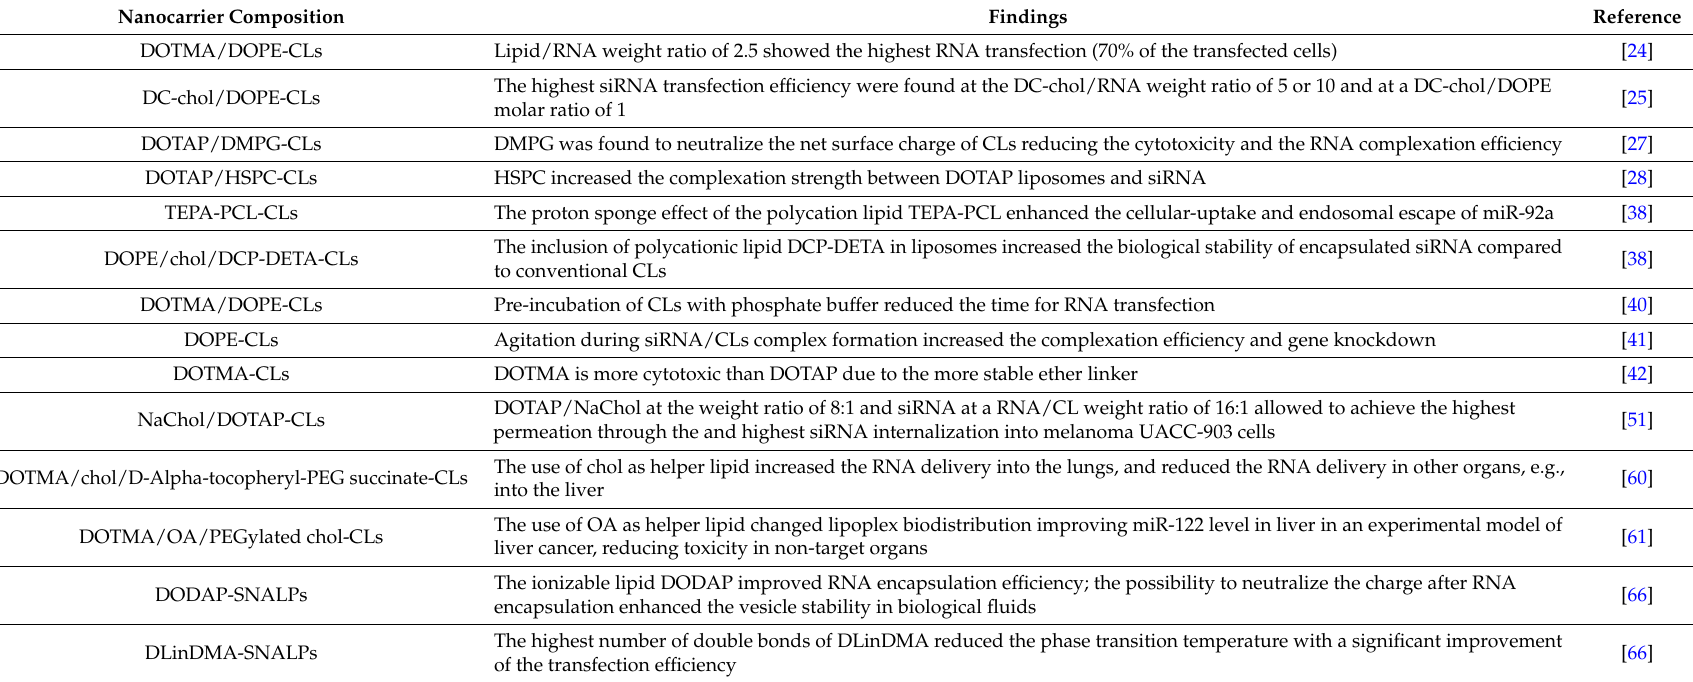
Table 1. Summary table of the most meaningful findings in ncRNA delivery with lipid